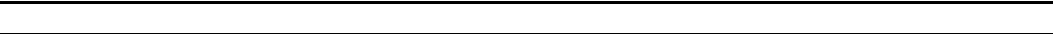
Table 3. Efficacy of HM ointment in HSV-2 genital infection